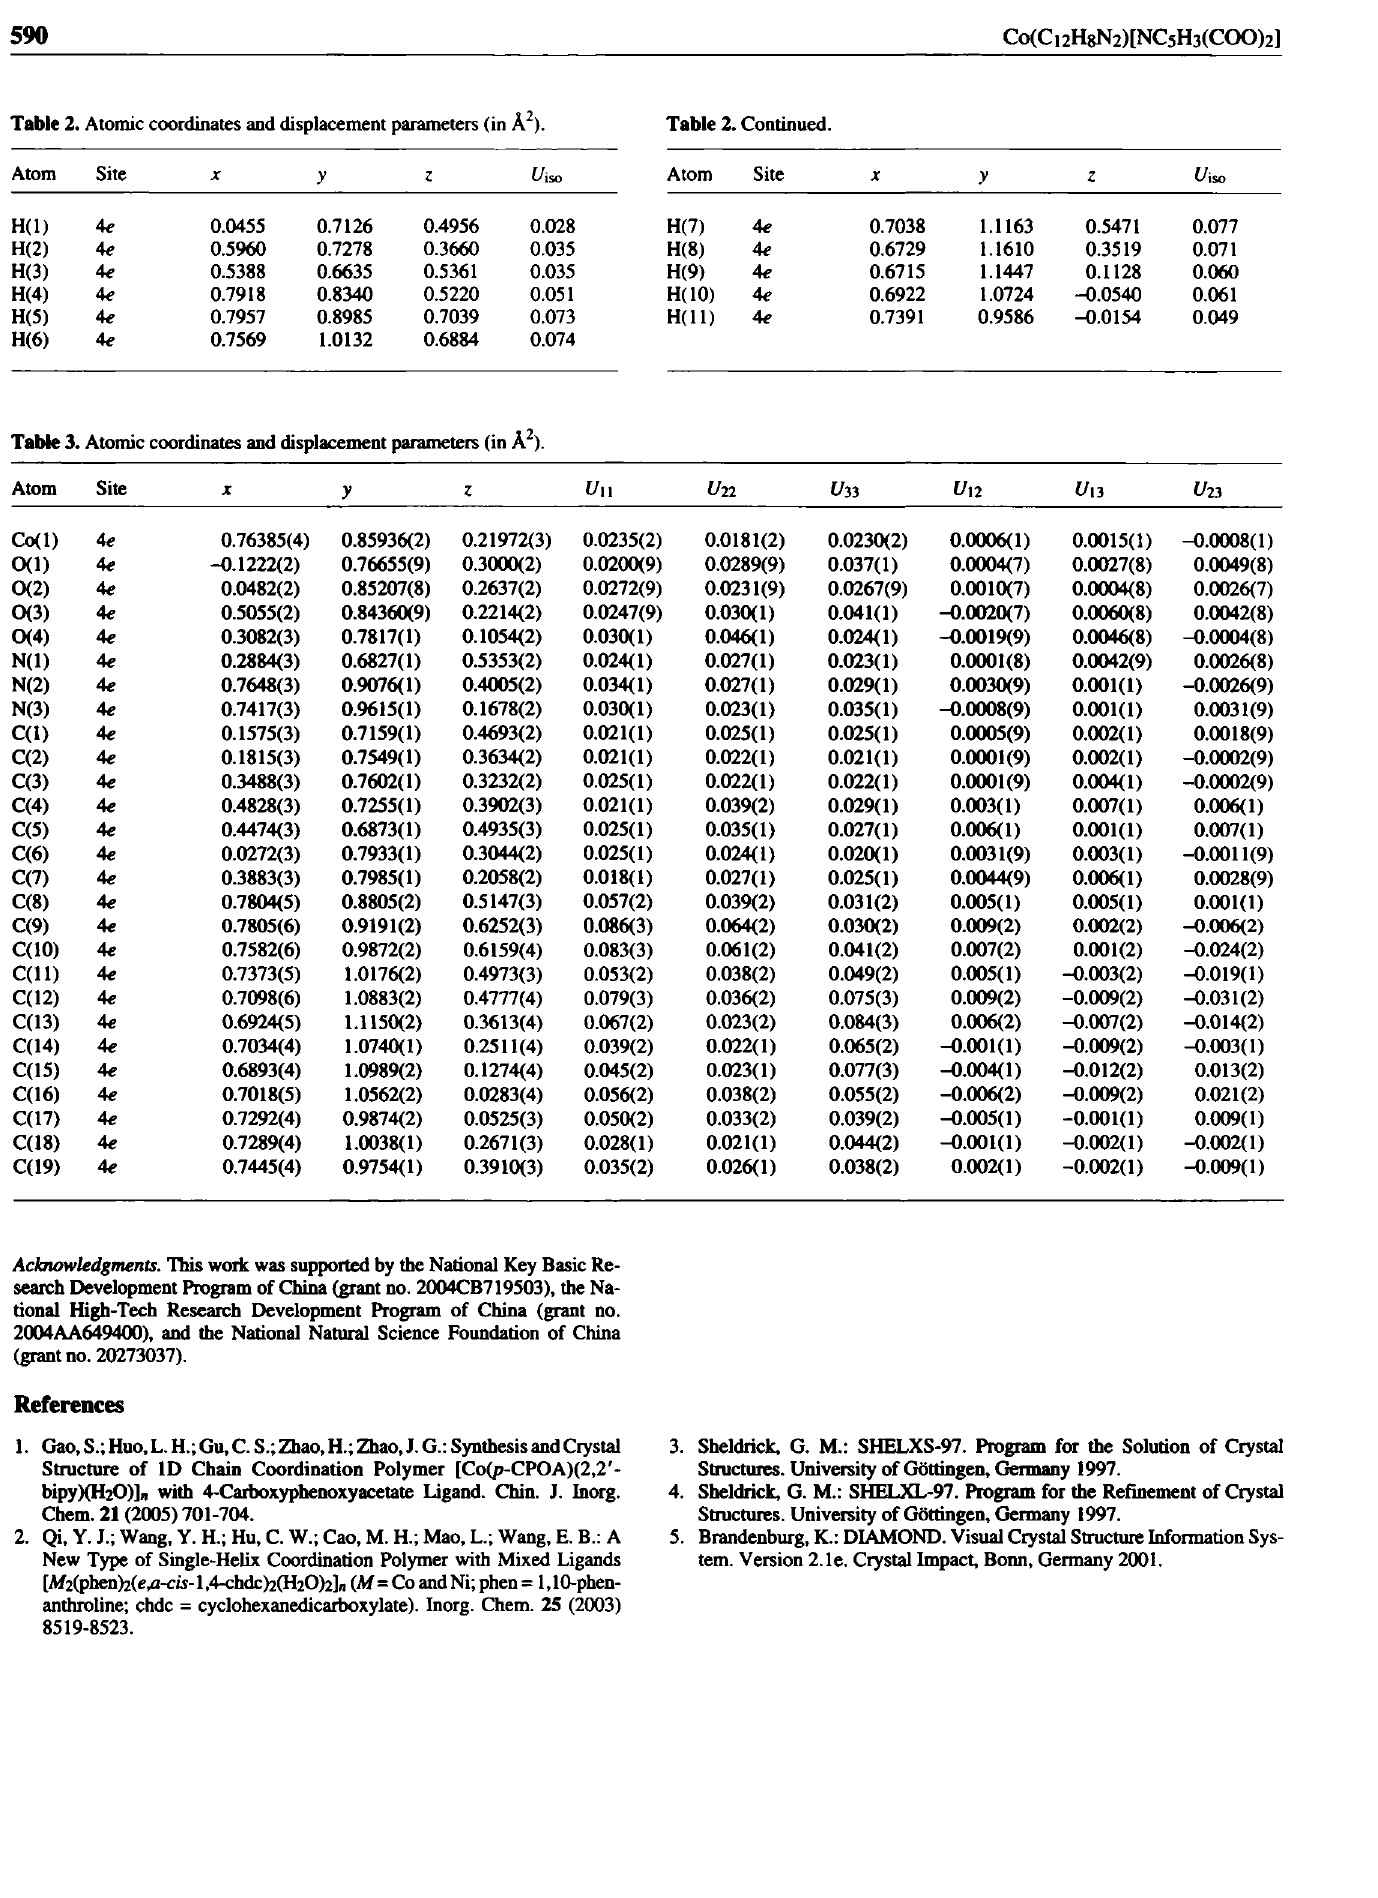
Table 2. Atomic coordinates and displacement parameters (in Ä 2 ).